Question: Looking at the figure, what chart type is it?
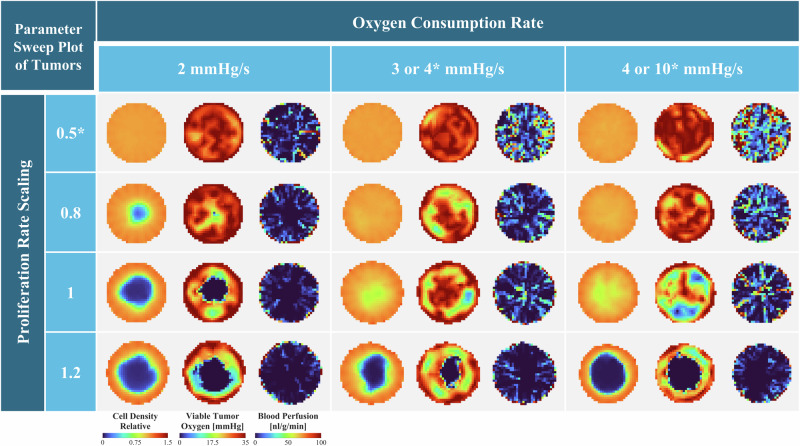
Answer: line